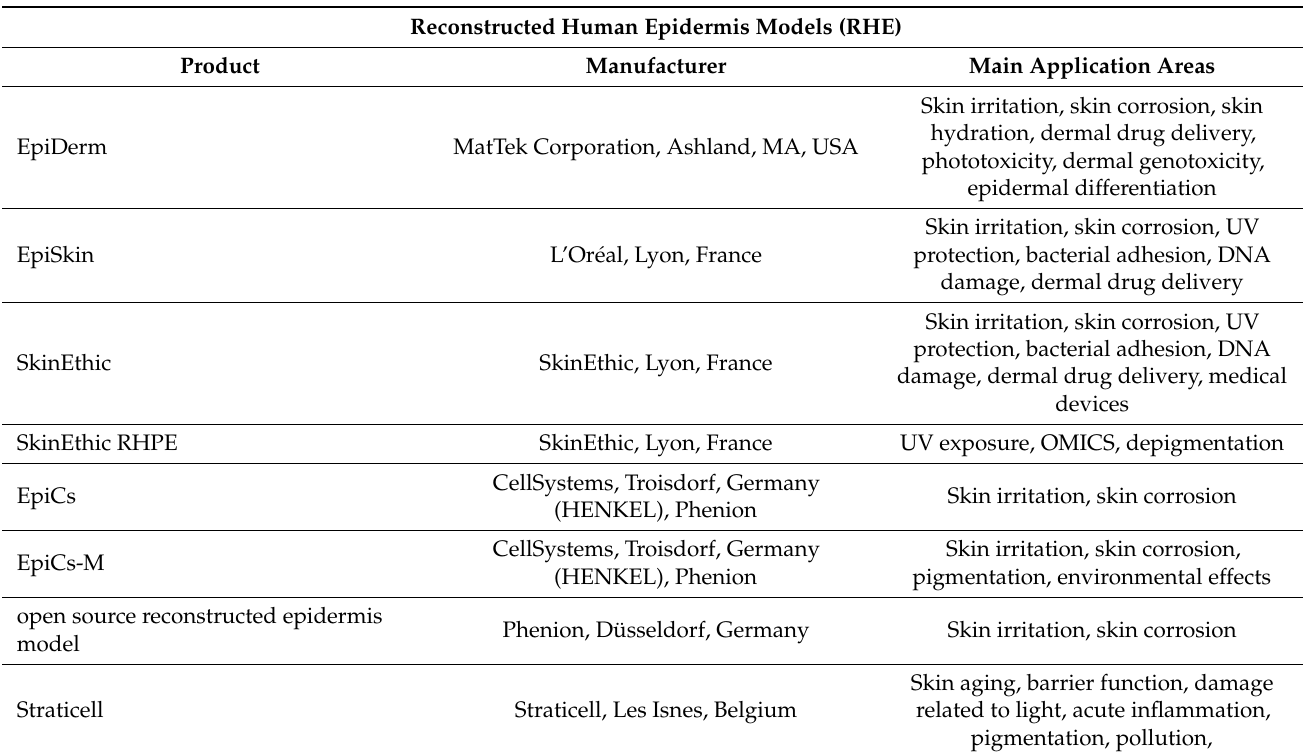
Table 4. Application possibilities of marketed RHE and LSE